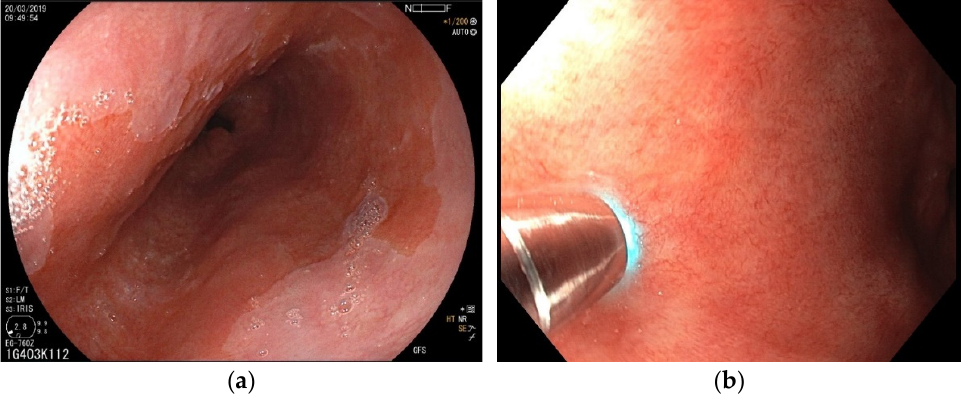
Figure 3. (a) Endoscopic view of the long segment of BE. ( b ) Endoscopic view of nondysplastic BE